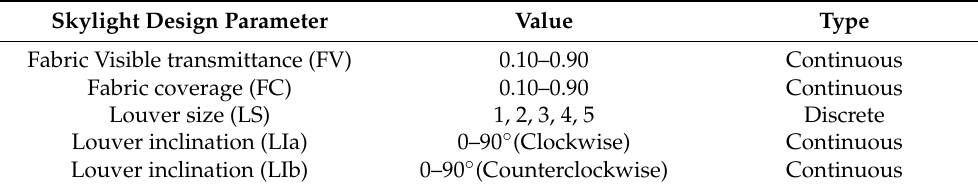
Table 6. Shading design